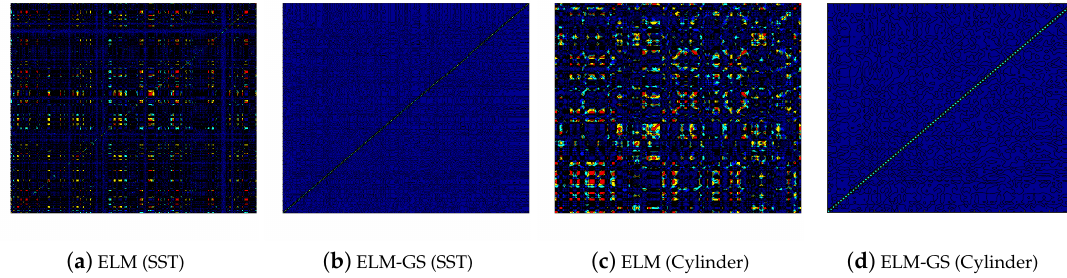
Figure 9. Φ T Φ contour plot of ELM and ELM-GS basis for both cylinder wake and sea surface temperature (SST) data. Red indicates a value of one, and blue indicates a value of